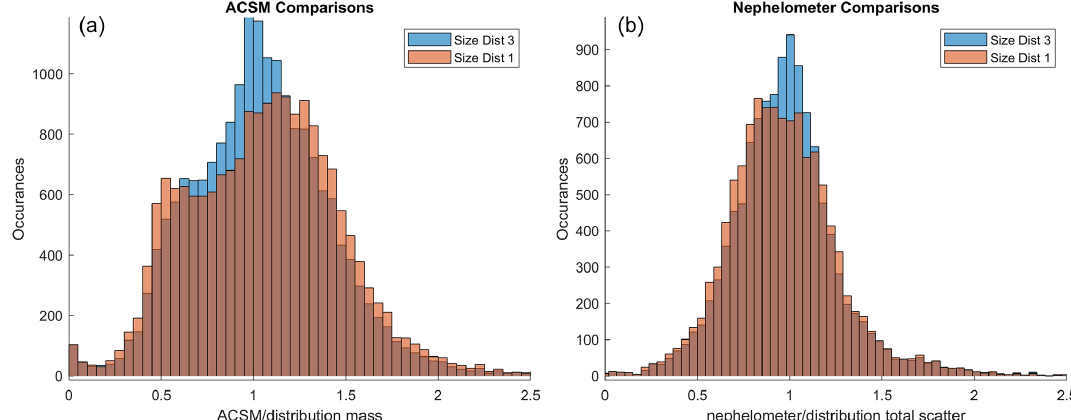
Figure A3. Statistical comparisons of the agreement between measured quantities ( a is ACSM aerosol mass concentrations; b is PM 10 nephelometer scattering coefficients) and those estimated from either the SD1 or SD3 size distributions. The x axes show the comparisons as ratios, where a ratio of 1 indicates perfect agreement.